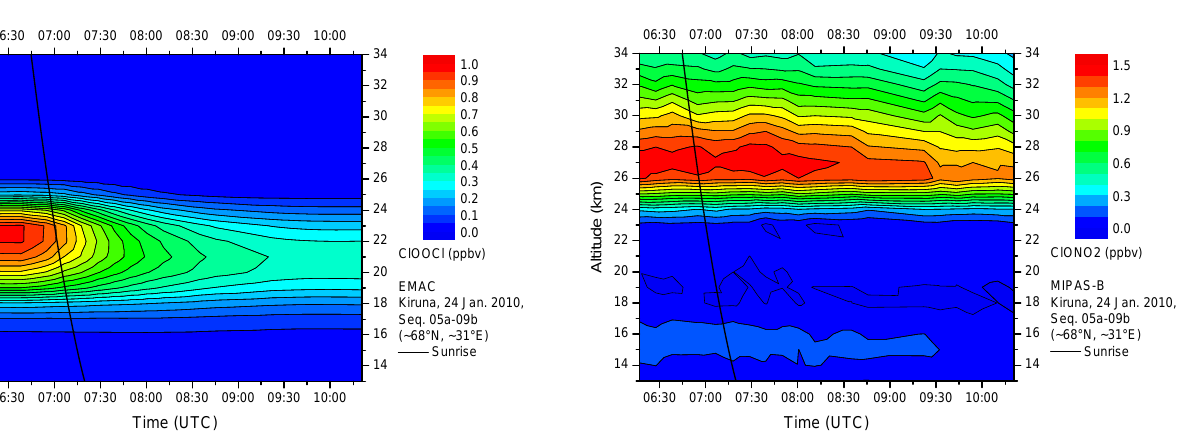
Fig. 6. Top panel: Measured and modelled build-up of ClO at 23 km. ClOOCl absorption cross sections JPL02 (Sander et al. 2003) were used for the EMAC standard run. A sensitivity run was performed using new ClOOCl cross sections JPL11 (Sander et al. 2011). The delay in the observed ClO build-up is clearly visible. “SR” denotes astronomical sunrise. Middle panel: ClOOCl photolysis frequencies ( J ClOOCl ) as calculated with the TUV (version 5.0) radiation model. For cloudless conditions, a ground surface albedo of a = 0.3 was assumed. Clouds in different altitudes with typical optical thicknesses ( τ ) have been taken into account (bluish curves lie close together). Photolysis frequencies from EMAC and MIPAS-B (estimated assuming steady state, see text) are shown for comparison. While tropospheric clouds have no significant influence on the photolysis rate, PSC strongly affect J ClOOCl . Bottom panel: Ratio of the direct to total fraction of the ClOOCl photolysis frequency as